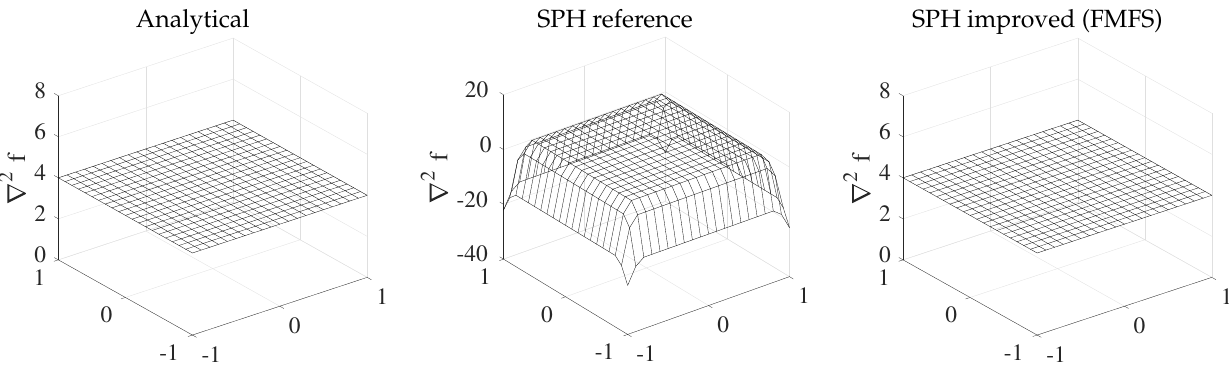
Figure 3. Reconstruction of the Laplacian operator acting on a 2D quadratic